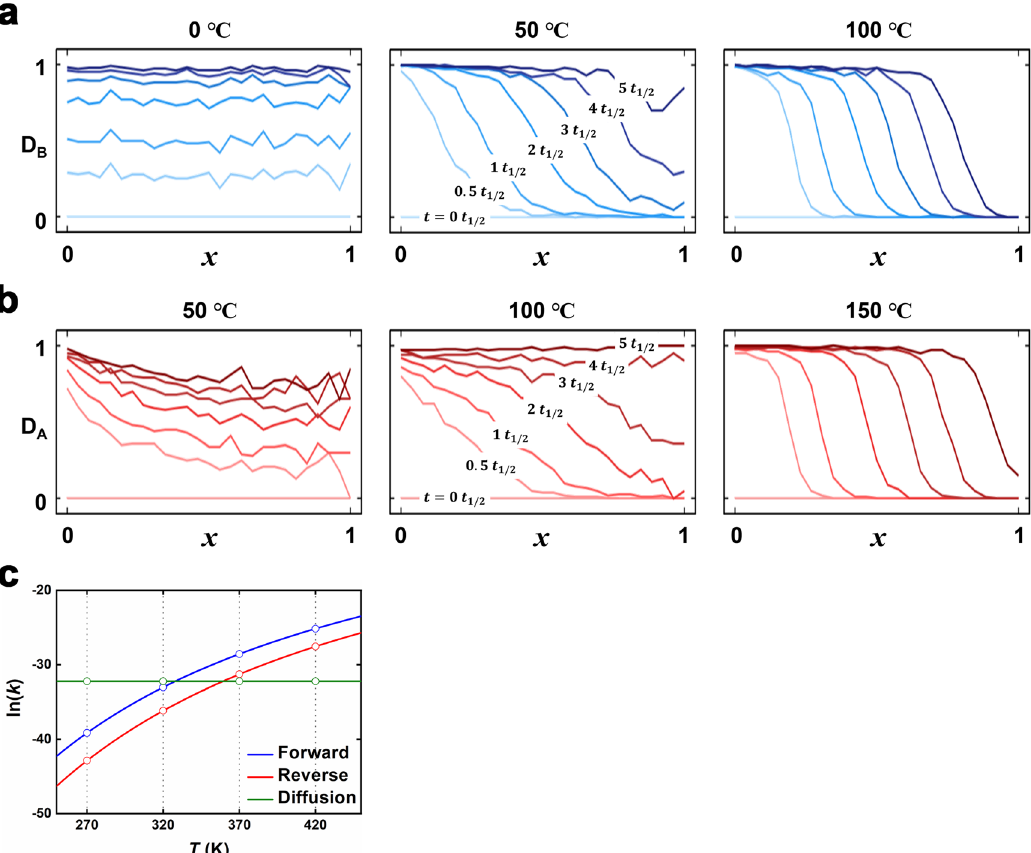
Fig. 5 Mean spatial distributions, D MAP/MBE ( x , t ; T ), of AP ligated to a metal (MAP) and BE ligated to a metal (MBE) in the hexagonal cell. a D MAP/MBE ( x , t ; T ) during forward pillar exchange at 0, 50, and 100 °C over radial factor x and normalized time t . b D MAP/MBE ( x , t ; T ) during reverse pillar exchange at 50, 100, and 150 °C over radial factor x and normalized time t . Red and blue lines in a and b represent the mean spatial distributions of MAP and MBE, respectively. c Temperature dependence of the rate constant ( k ) for kMC simulations in the range of 0 – 150